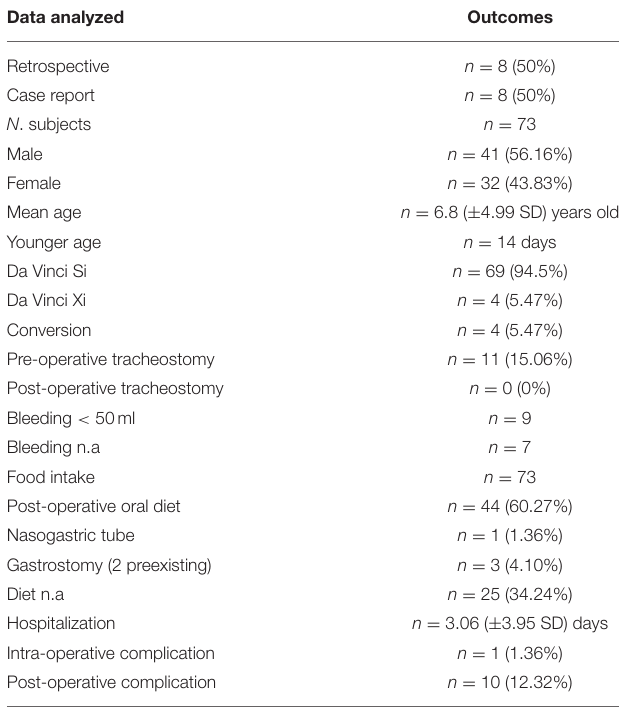
TABLE 1 | Summary table of the study